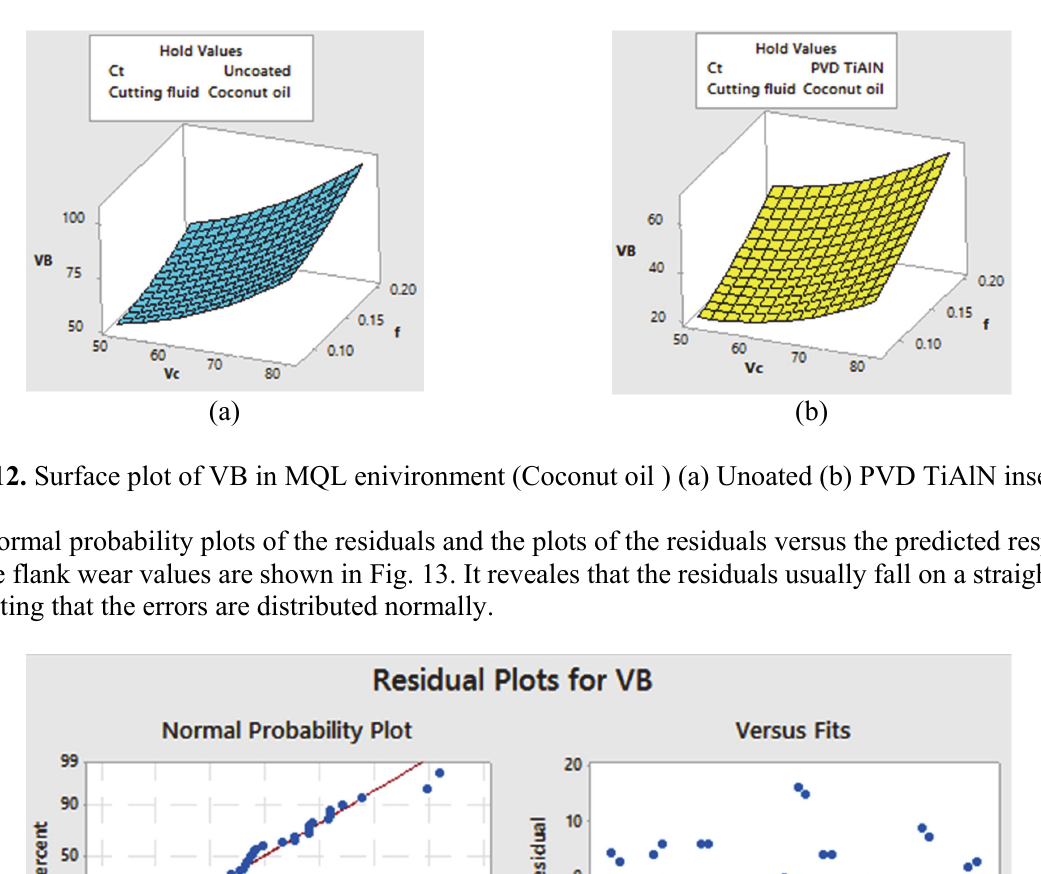
Fig. 11. Surface plot of VB in MQL enivironment (Palm oil ) (a) Unoated (b) PVD TiAlN insert